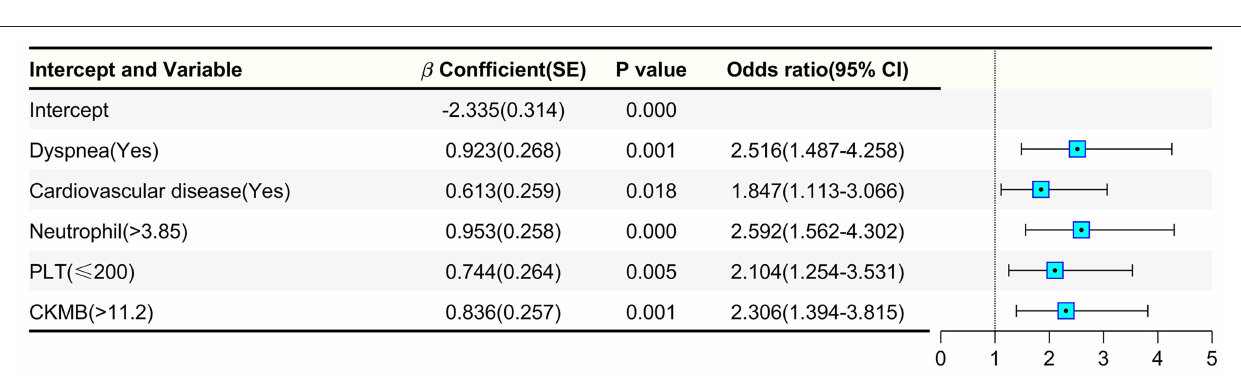
FIGURE 4 | The weight coefficient was calculated by two